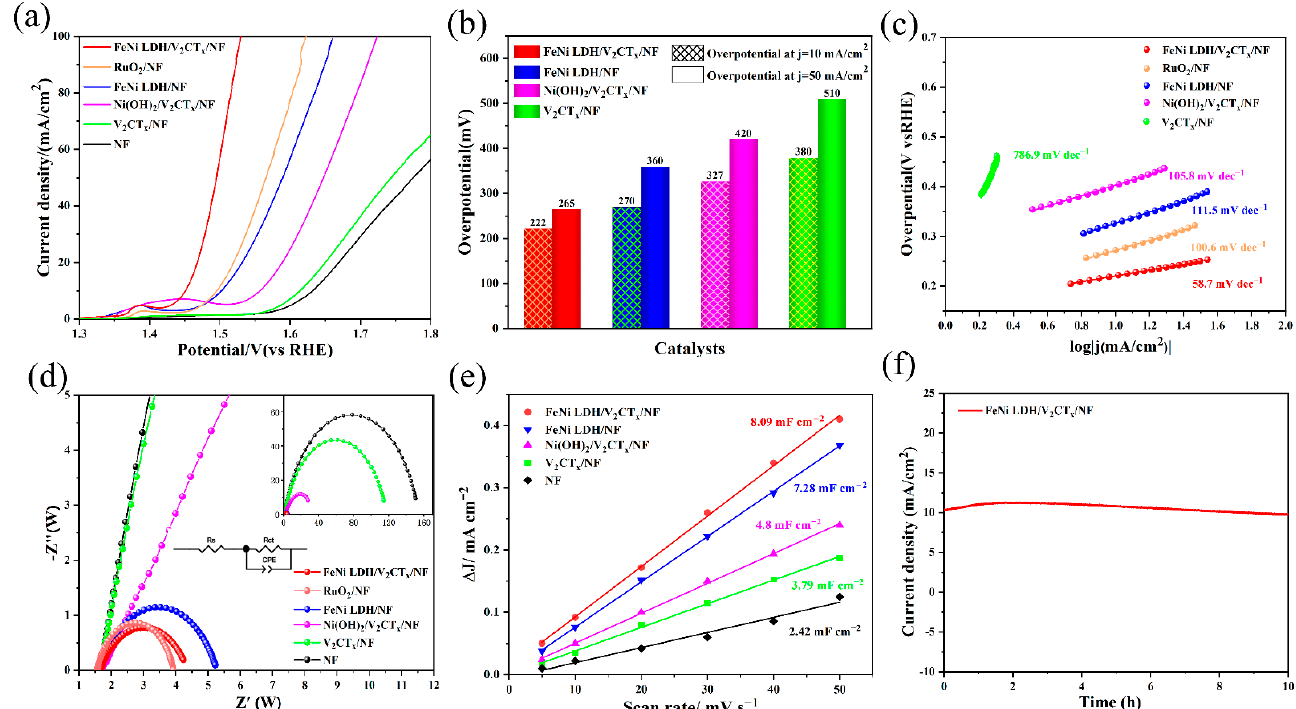
Figure 3. OER performances of prepared electrocatalysts. ( a ) LSV curves. ( b ) The overpotential of electrocatalysts. ( c ) Tafel plots. ( d ) EIS patterns. ( e ) C dl of samples. ( f ) Stability measurements of FeNi LDH/V 2 CT x /NF.